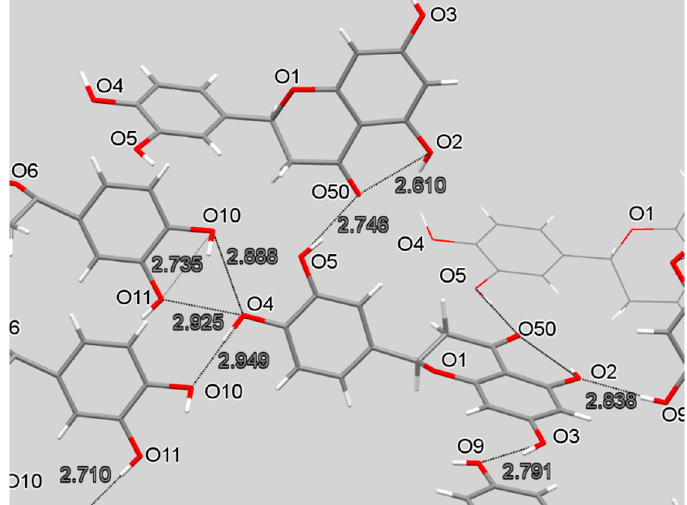
Figure 10. H-bond network of eriodictyol.